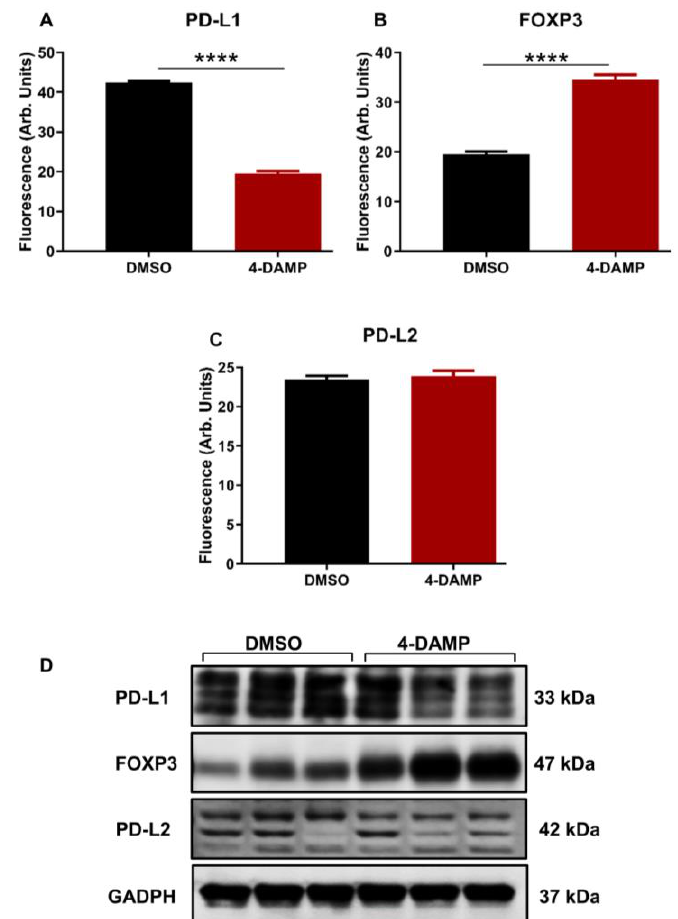
Figure 5. Effect of 4-DAMP on the expression of PD-L1 and FOXP3 in vivo. Bar graphs displaying the mean fluorescence of PD-L1 ( A ), FOXP3 ( B ), PD-L2 ( C ), and images of Western blot bands ( D )